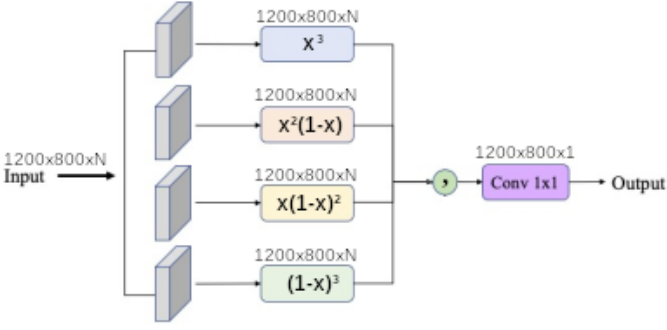
Figure 5. Polynomial model with Bernstein expansions between B 4,1 and B 4,4